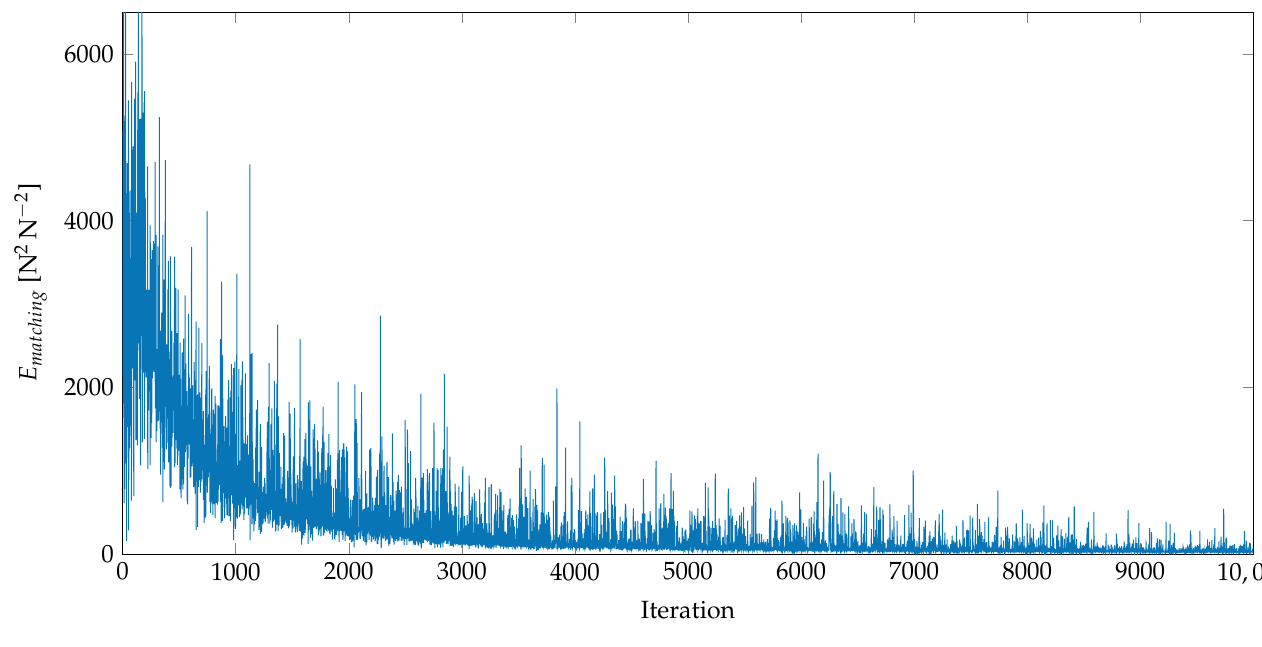
Figure 4. Optimization criterion E matching over optimization